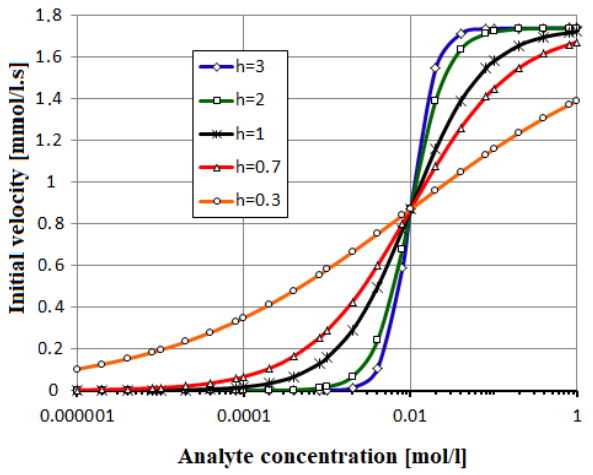
Figure 4. The enzymatic reaction is depicted by Hill model, with h = 0.3, 1, 2, 4.